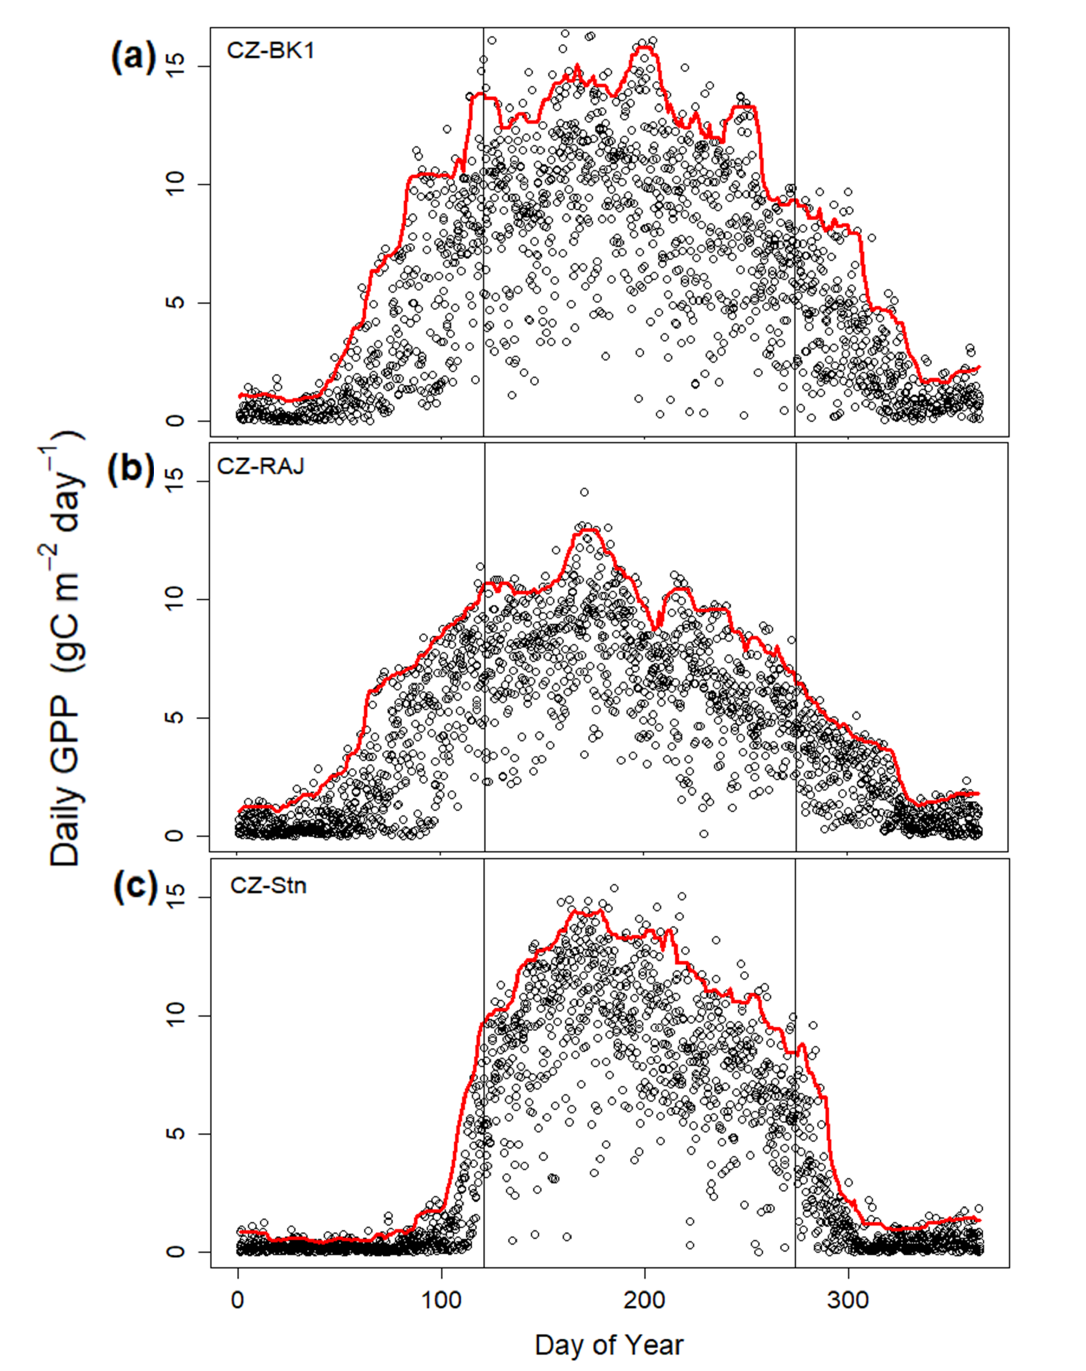
Figure 2. Annual trend of the daily potential gross primary productivity (red line) using daily sums of gross primary productivity (GPP) for ( a ) the wet spruce forest in Bílý K˘rí˘z (CZ-BK1), ( b ) the dry spruce forest in Rájec (CZ-RAJ), and ( c ) the beech forest in Štítná (CZ-Stn) from 2012 to 2016. The vertical lines represent the main growing season period